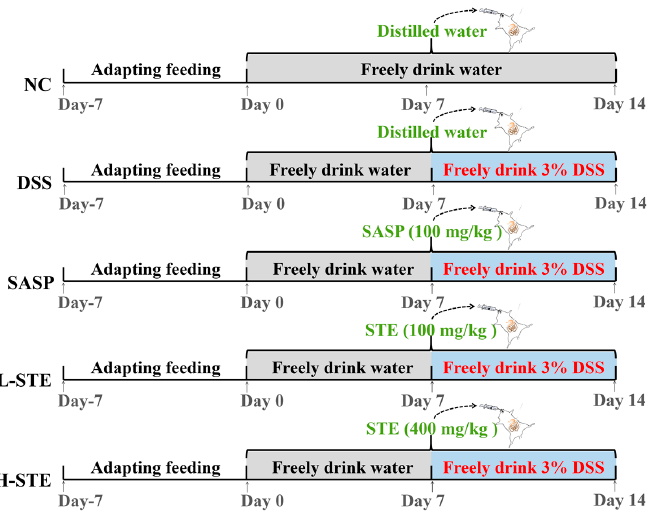
Figure 1. Schematic representation of the experimental design. NC, normal control group; MC, DSS-induced UC model group; SASP, suffasalarin intervention group at the dose of 100 mg/kg; L-STE, STE intervention group at the dose of 100 mg/kg; H-STE, STE intervention group at the dose of 400 mg/kg.